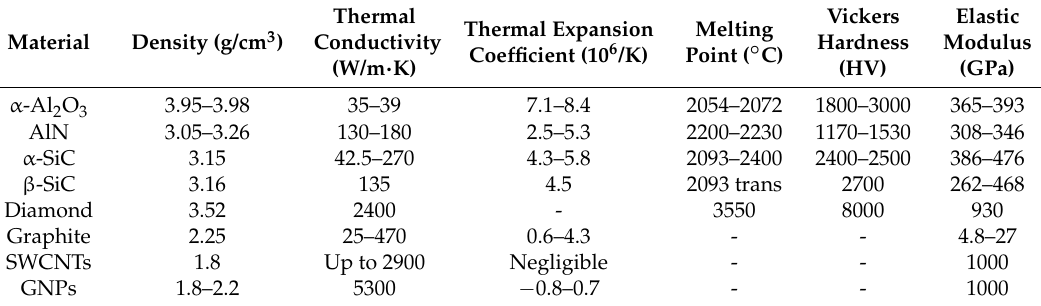
Table 1. The characteristics of common reinforcements [61–65].